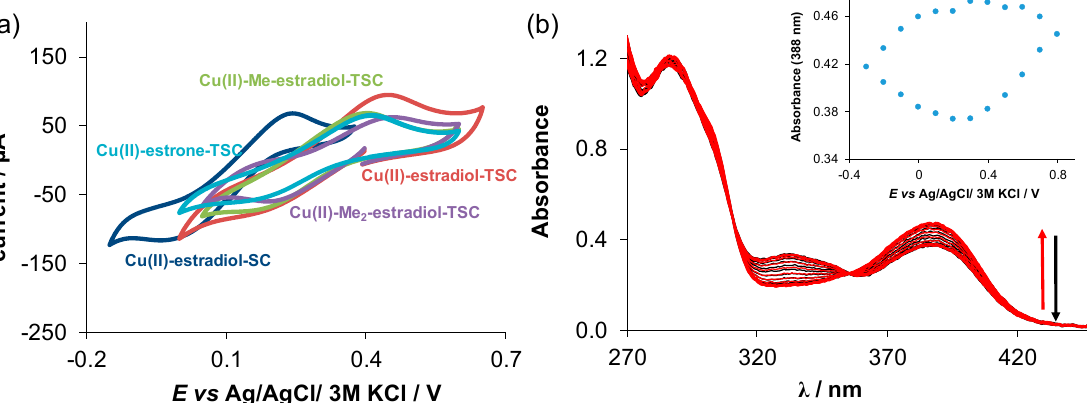
Figure 6. (a) Cyclic voltammograms of the Cu(II) ‐ (T)SC (1:1) chemical systems in 90% ( v/v ) Figure 6. ( a ) Cyclic voltammograms of the Cu(II)-(T)SC (1:1) chemical systems in 90% ( v/v ) DMSO/H 2 O